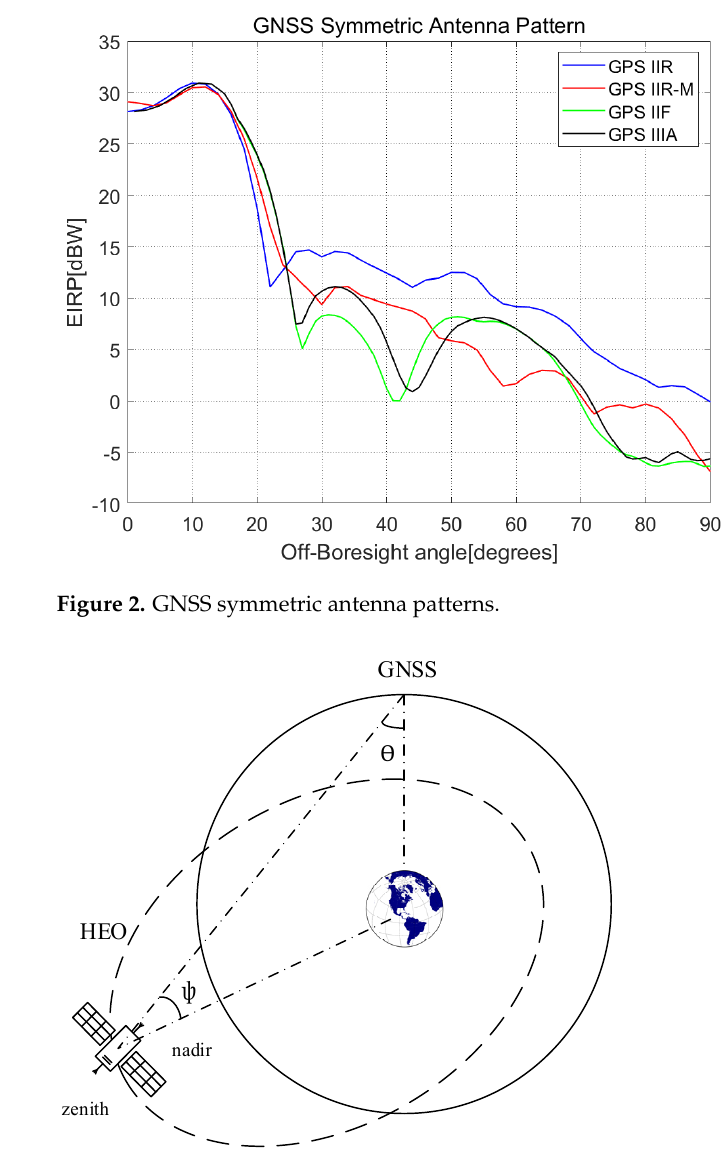
Figure 3. Physical visibility of HEO spacecraft.